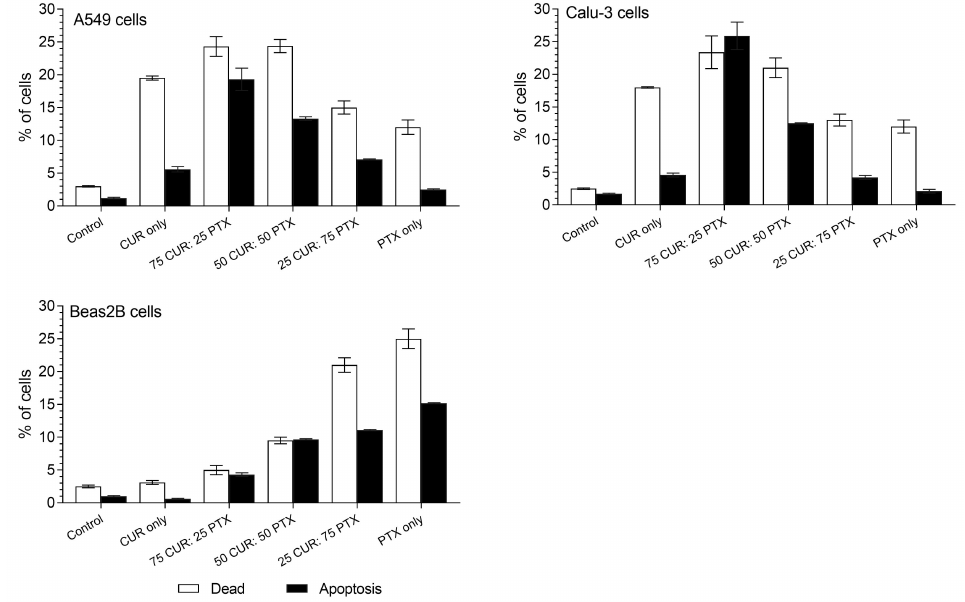
Figure 5. The effect of PTX, CUR and CUR/PTX combination on the apoptosis of A549, Calu-3 and Beas-2B cells. Control indicates untreated cells. Data are expressed as mean ± SD of three